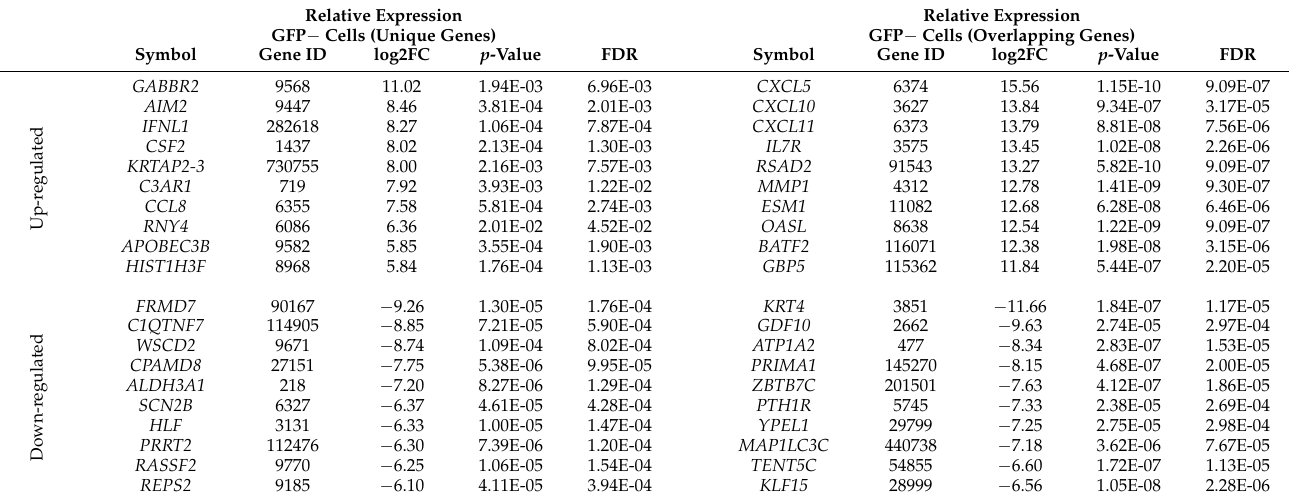
Table 2. Top ten up- and down-regulated differentially expressed genes in GFP − cells (uninfected bystander) based on their log2FC